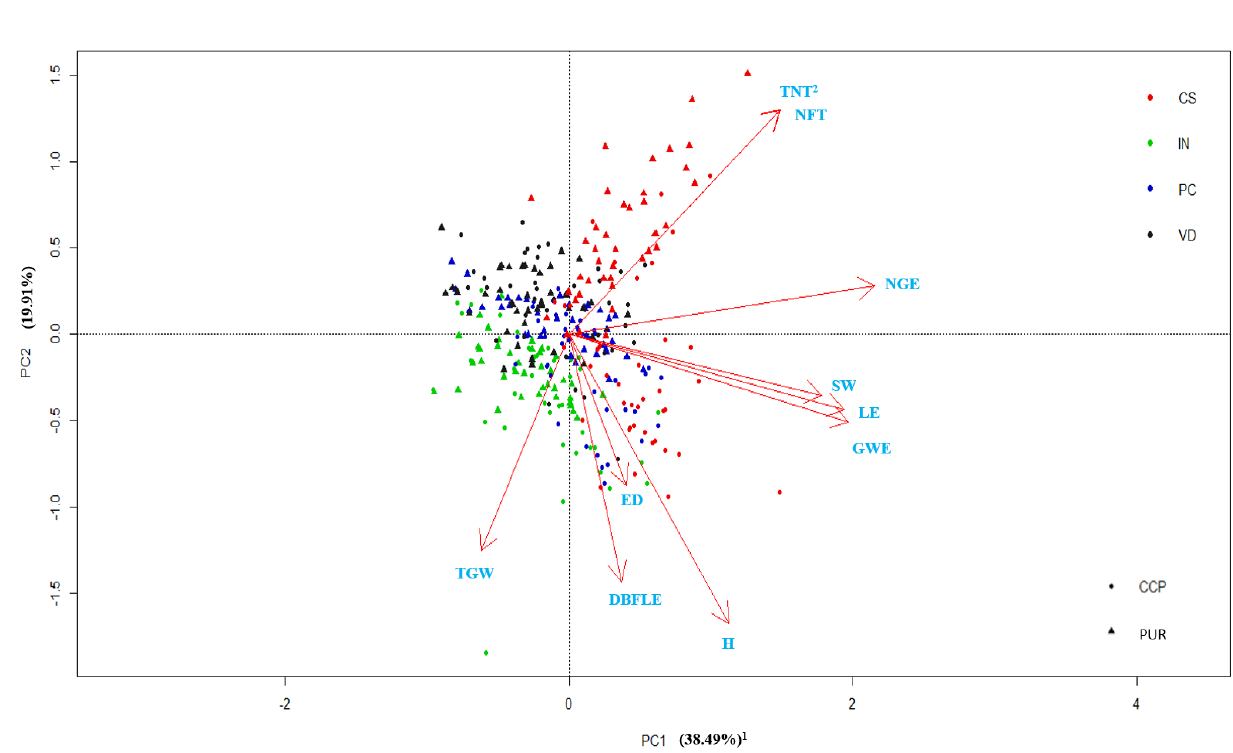
Figure 3. Graphic representation of the first two components of the Principal Components Analysis. The different colours distinguish the four different sites: VD, IN, PC and CS. CCP = Composite Cross Population, PUR = Pure line. 1 The percentage indicates the contribution of the component to the explanation of the total variation within the dataset. 2 Red arrows indicate measured parameters. Their abbreviations are detailed in Table